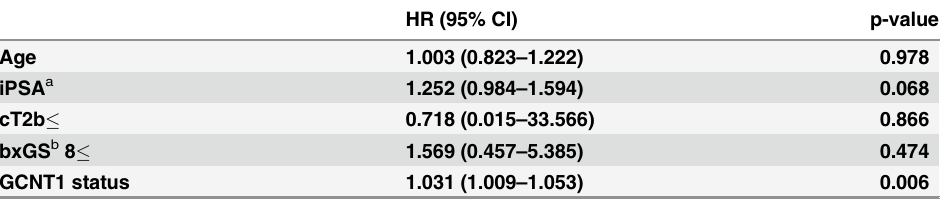
Table 2. Logistic regression analyses of risk factors for extracapsular extension of prostate